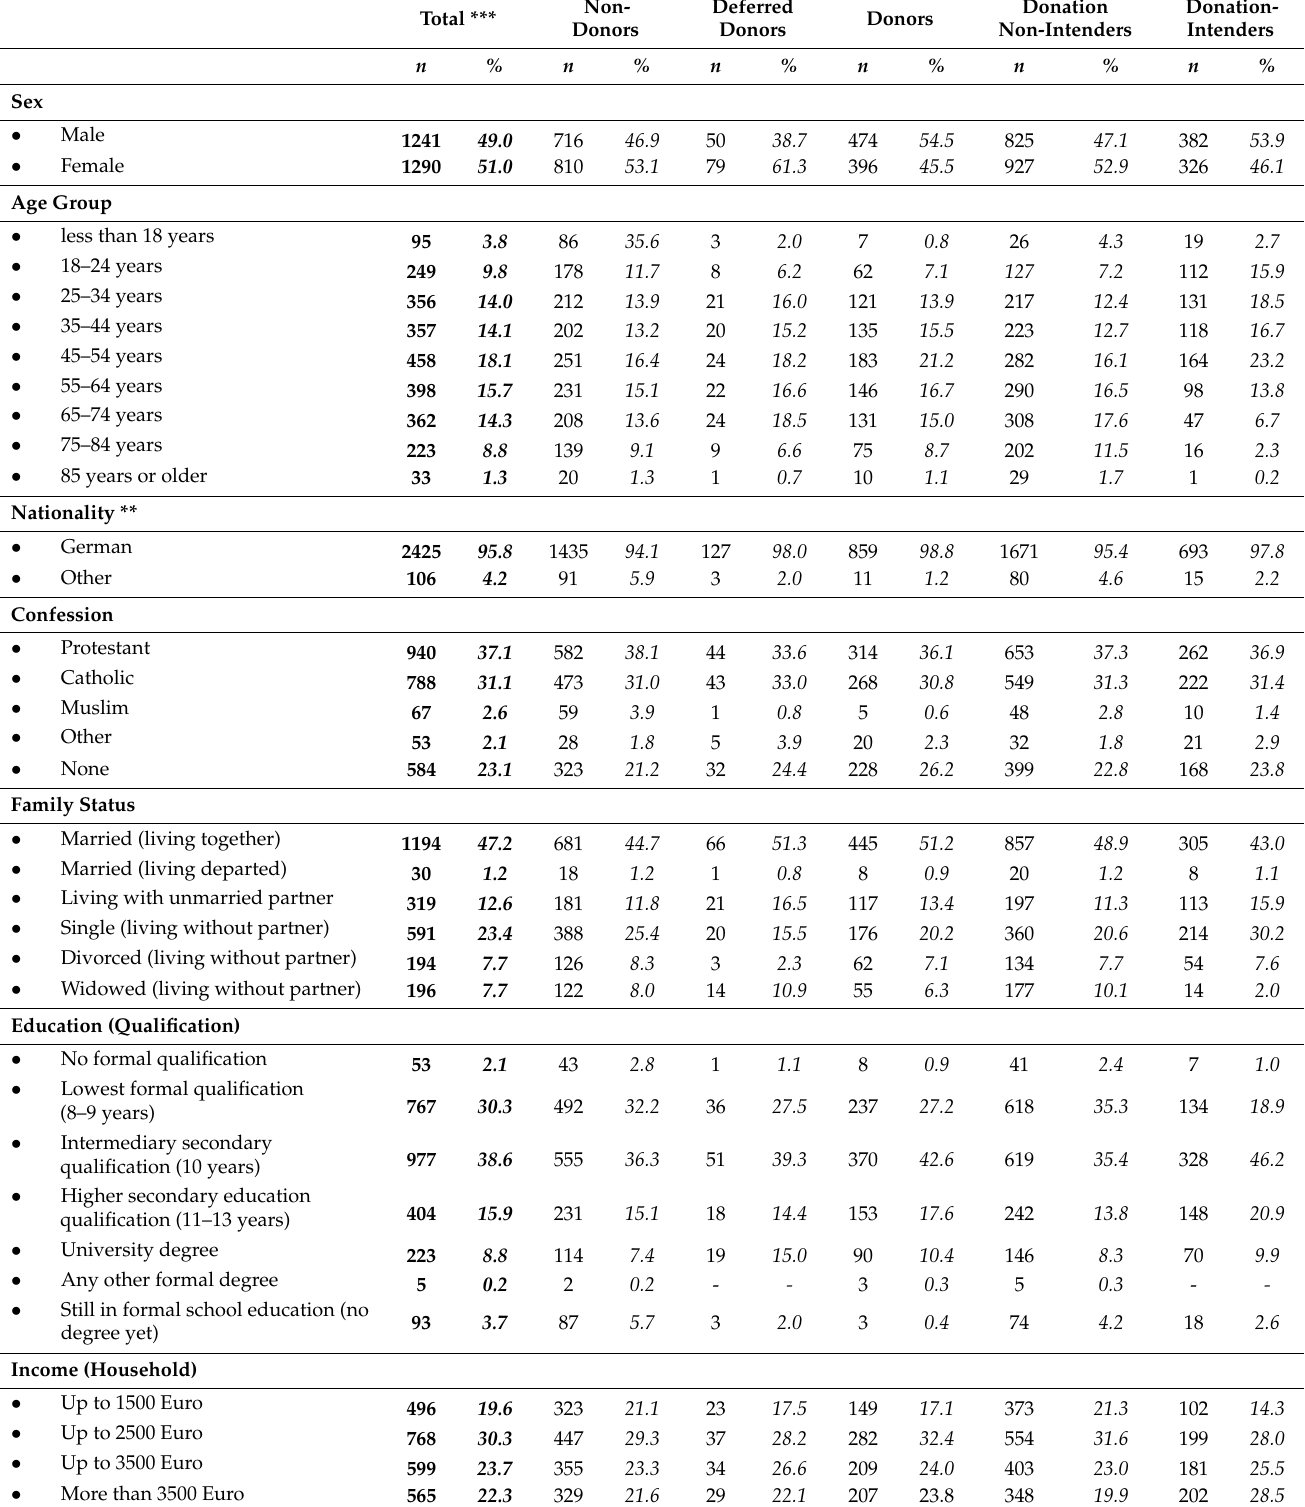
Table 1. Sociodemographic characteristics of study sample ( n = 2531, weighted)